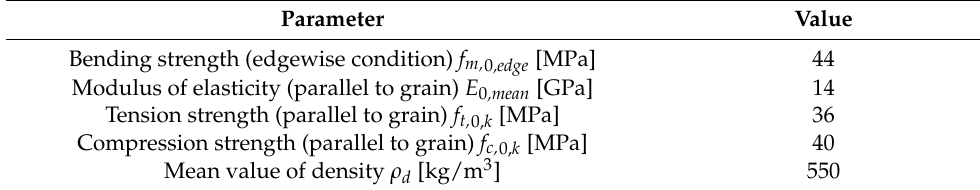
Table 1. Selected mechanical and physical properties of LVL [32].